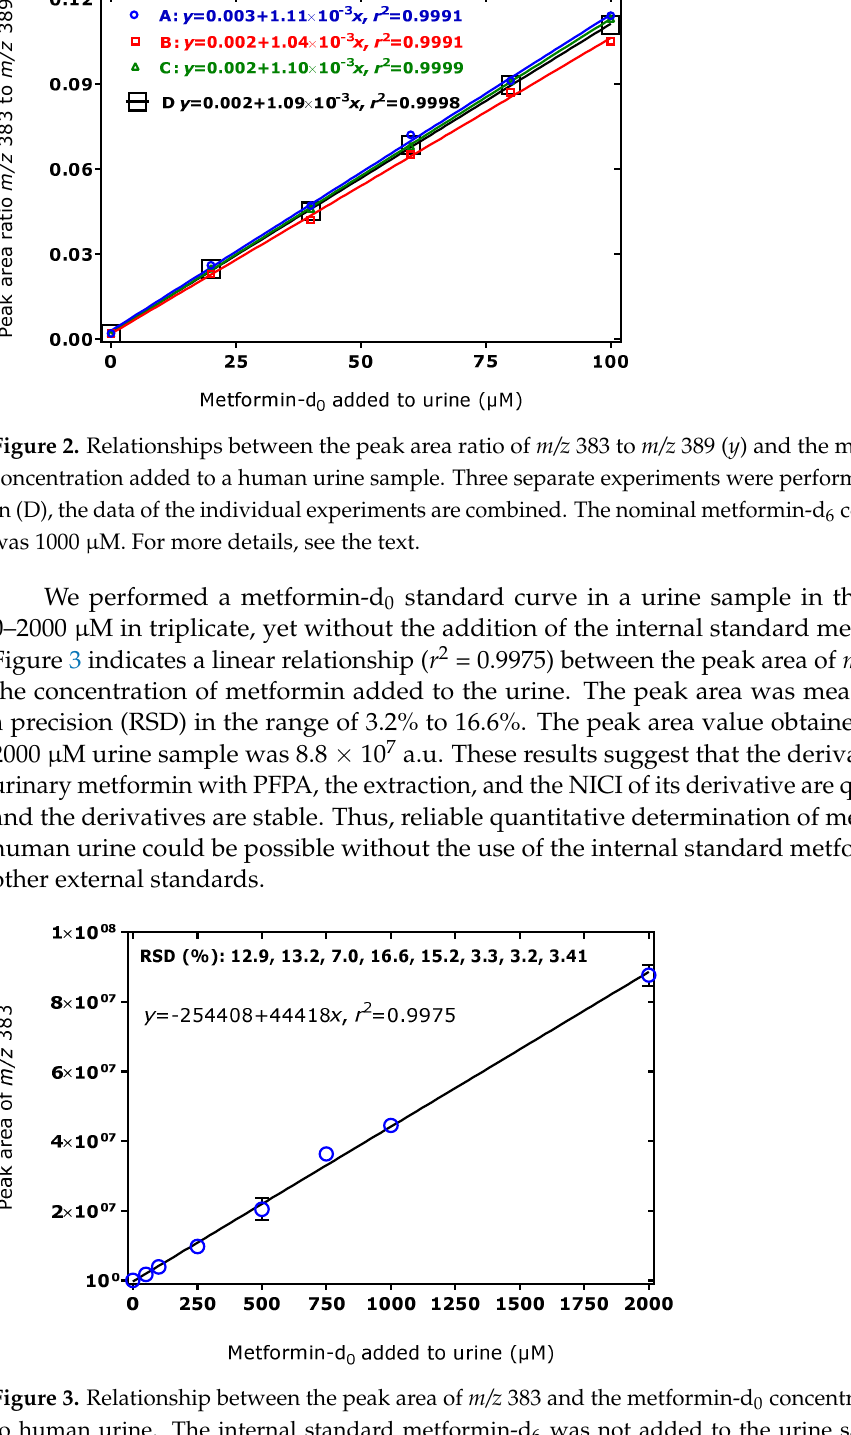
Figure 3. Relationship between the peak area of m/z 383 and the metformin-d 0 concentration added to human urine. The internal standard metformin-d 6 was not added to the urine samples. All three 10- µ L aliquots of the human urine samples were spiked with metformin-d 0 at the indicated concentrations and worked out as described in the text. Then, each 1- µ L aliquot of toluene extract (200 µ L) was injected and the mass fragment m/z 383 (see Figure 2 for A) for metformin-d 0 was monitored. Data are shown as mean with the standard deviation. The inserted RSD values are listed